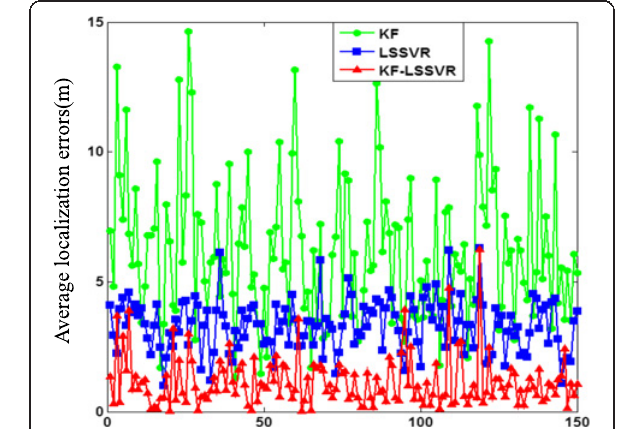
Fig. 6 Errors of three kinds of